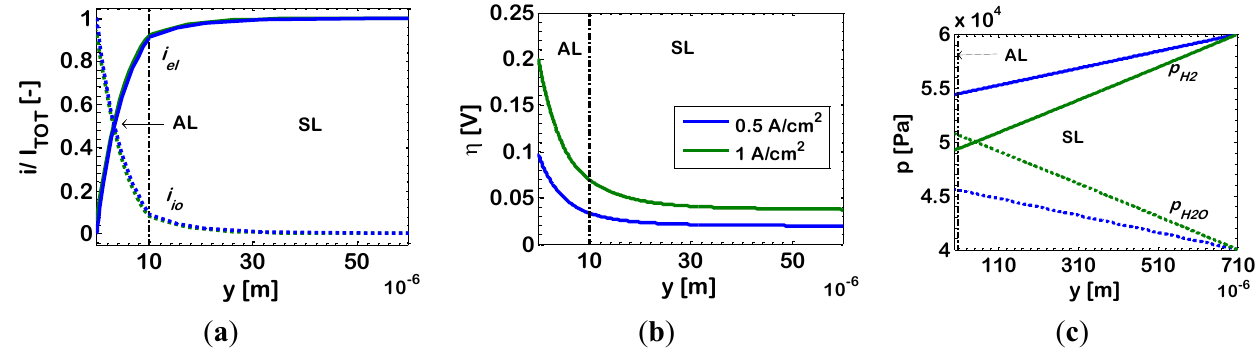
Figure 3. Bi-layered Ni-YSZ anode with Ni volumetric fraction in the AL ϕ (Case 2 ). Simulation results at temperature T = 1073 K; overall current density: c I = 1 A/cm 2 , and I = 0.5 A/cm 2 : ( a ) ionic (dotted lines) and electronic tot tot (solid lines) currents densities; ( b ) overpotential (η); and ( c ) partial pressures of hydrogen ( p ) and water ( p H2 H2O